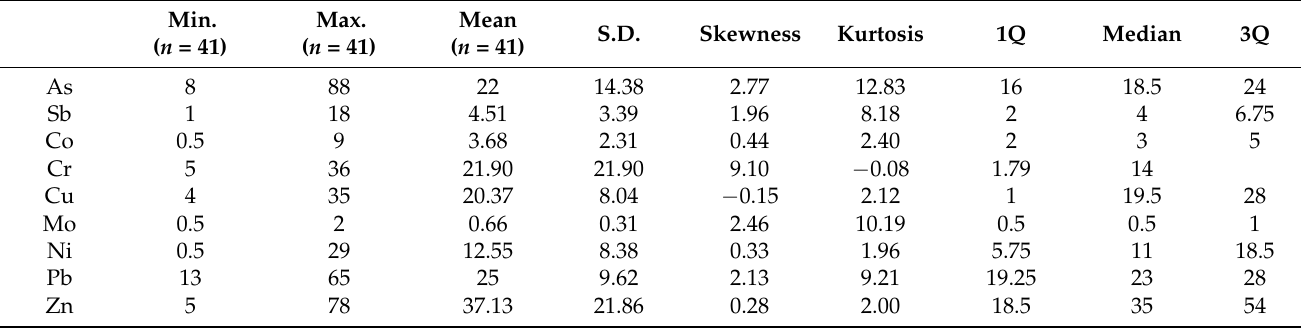
Table 1. Background PTEs concentration in soils from the western limb of the Valongo Anticline, after removing the outliers, in mg kg − 1 .